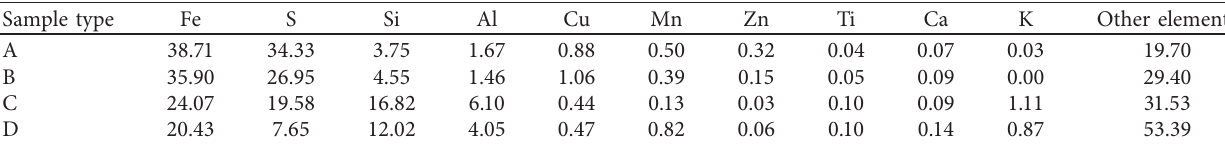
Figure 4: XRD spectra of four types of metal sulfide ore samples. (a) Class A ore sample; (b) Class B ore sample; (c) Class C ore sample; (d) Class D ore sample. Table 2: Elemental composition of four types of metal sulfide ore